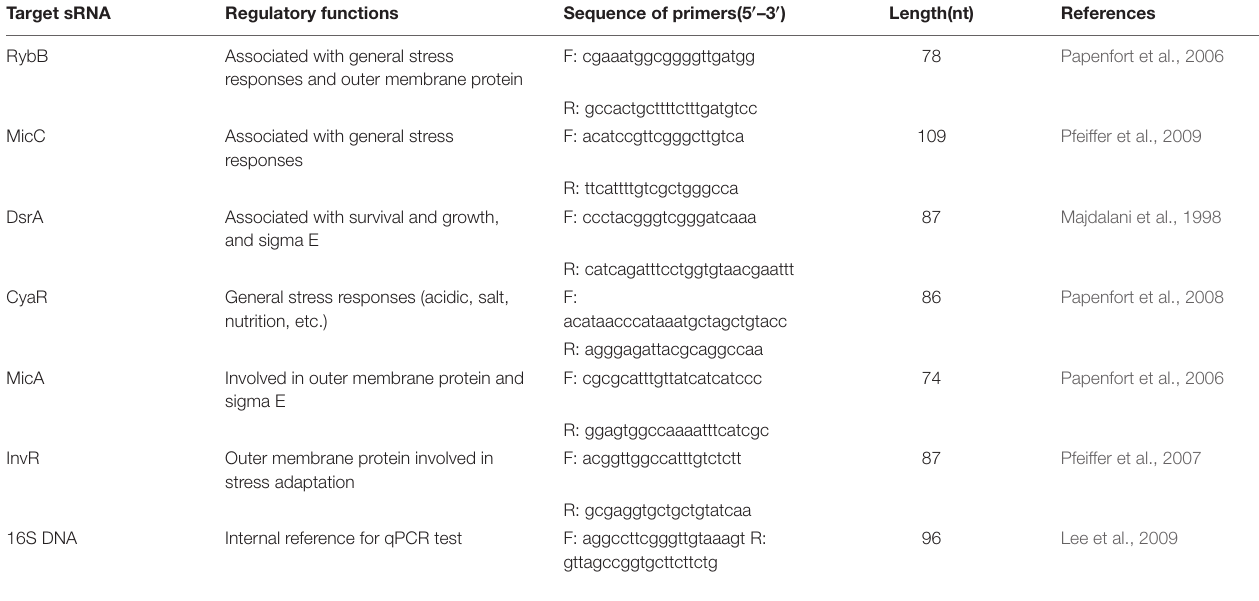
TABLE 1 | Information of primers